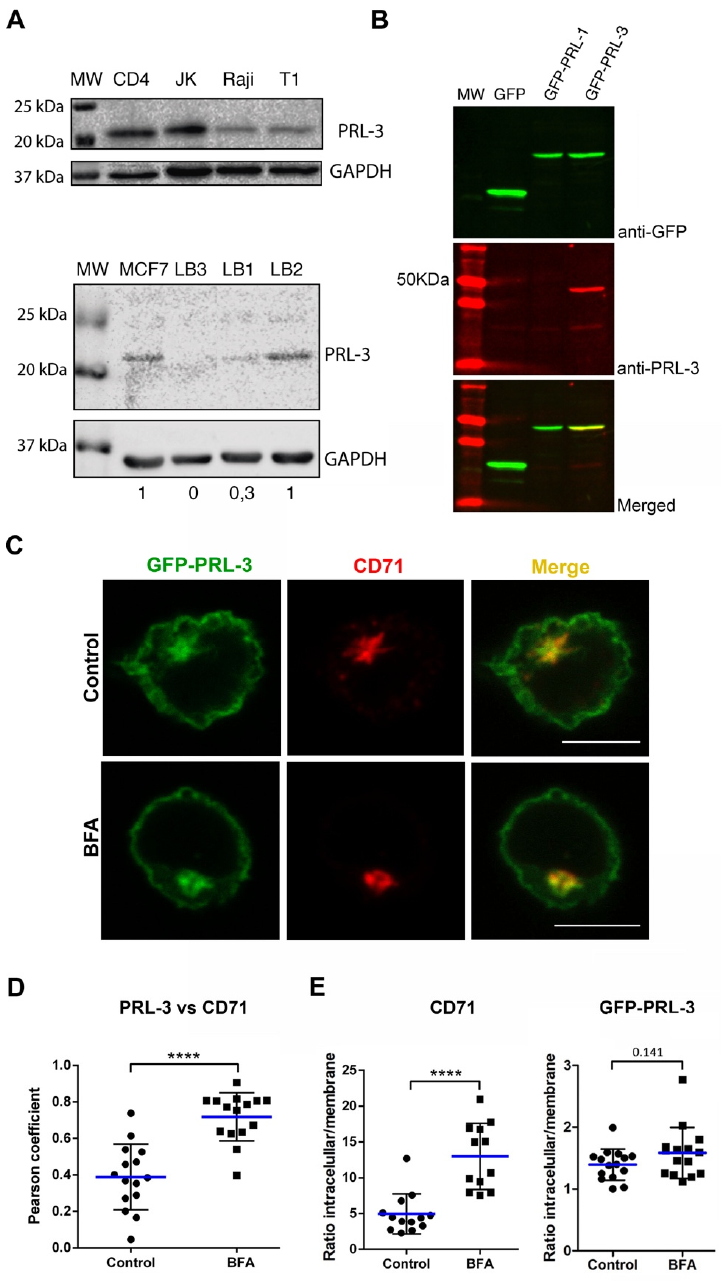
Figure 1. Expression and subcellular distribution of PRL-3. ( A ) Expression of endogenous PRL-3 assessed by Western blot. The cell type and antibody used are indicated. Lymphoblasts (LB) expanded from peripheral blood mononuclear cells (PBMCs) of three representative donors (LB1, LB2 and LB3) are shown. A lysate of MCF7 cell line was used as a positive control [20]. Numbers under the lower gels indicate the ratio PRL-3/GAPDH normalized to the positive control ( B ) Expression of the GFP- PRL-3, GFP-PRL-1 or GFP in JK cells analyzed by fluorescent Western blot. The green, red and merged images are shown. The antibody used in each channel is indicated. ( C ) Distribution of GFP-PRL-3 and